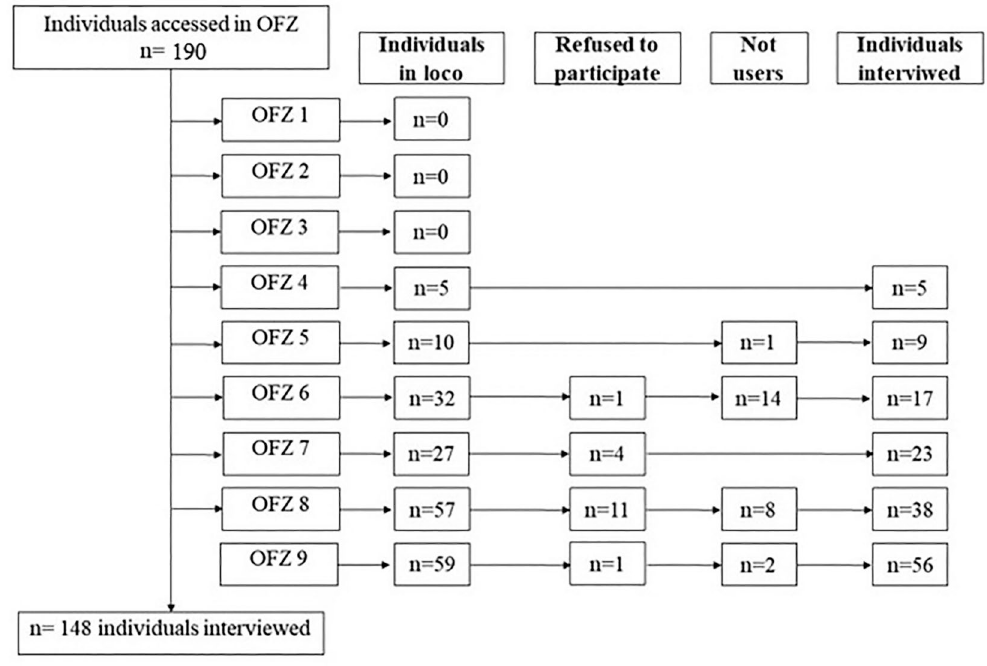
Figure 1 - Flow chart of the individuals included/interviewed in each outdoor fitness zone included in the study. OFZ = Outdoor Fitness Zone; OFZ1 = Praça Altamiro de Deus; OFZ = Praça Edgard F. da Silva; OFZ3 = Praça São Jorge; OFZ4 = Praça Hélio Fernandes de Oliveira; OFZ5 = Praça da Abadia; OFZ6 = Praça Dr. Jorge Frange; OFZ7 = Parque das Acácias; OFZ8 = Praça Pôr do Sol; OFZ9 = Praça G. M.